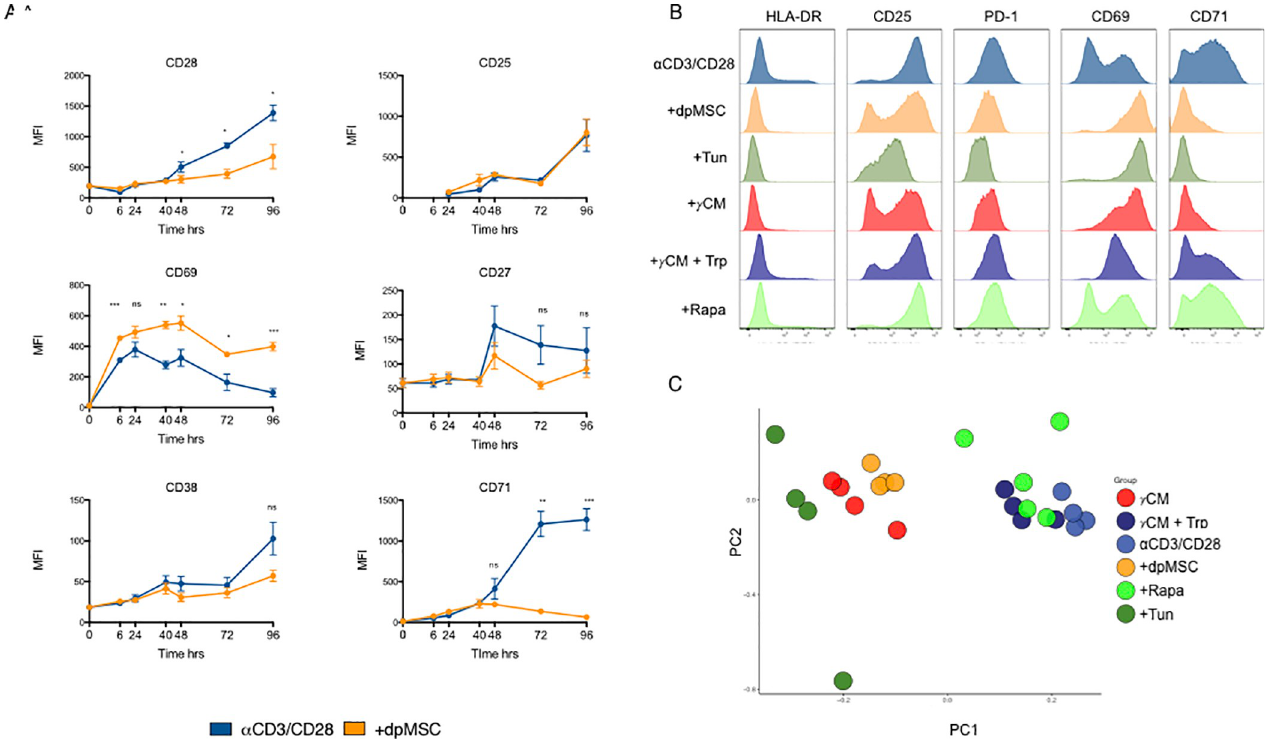
Fig 3. Cellular stress inhibits T-cell activation. (A) Flow cytometry analysis of T-cell activation marker expression (MFI) in α CD3/CD28-activated CD4 + T- cells cultured alone or in the presence of dpMSC (n = 4). (B) Representative histograms showing T-cell activation marker expression at 72 hours in α CD3/ CD28 activated CD4 + T-cells cultured alone, in the presence of dpMSC, Tunicamycin (Tun) 100% IFN γ -activated dpMSC CM or in IFN γ activated dpMSC supplemented with tryptophan and rapamycin (Rapa). ( C ) Principal component analysis of activated cell subset phenotypes in CD4 + T cells cultured under the conditions